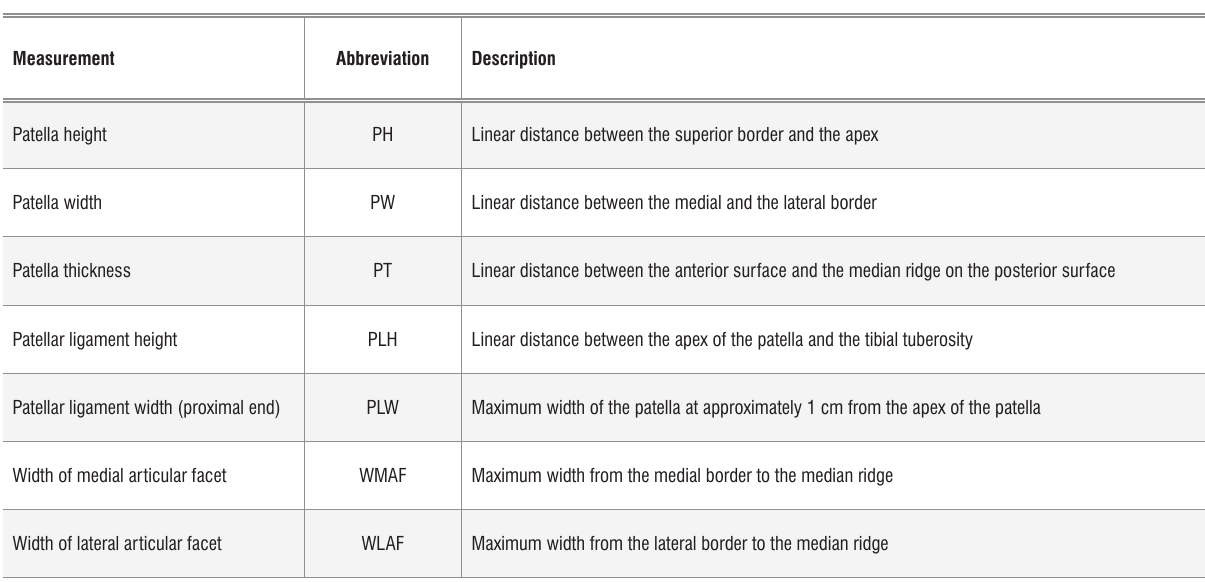
Description of measurements taken of the patella and patellar ligament